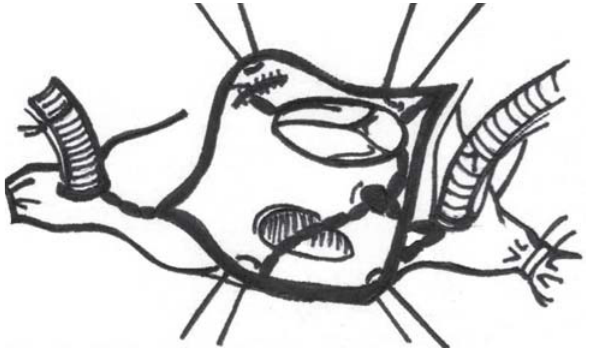
Fig. 1 -Aplicação de radiofrequência irrigada no epicárdio do átrio direito, unindo o sítio de canulação das veias cava superior Fig. 3 -Complementação do procedimento era feita com aplicação de linhas no átrio